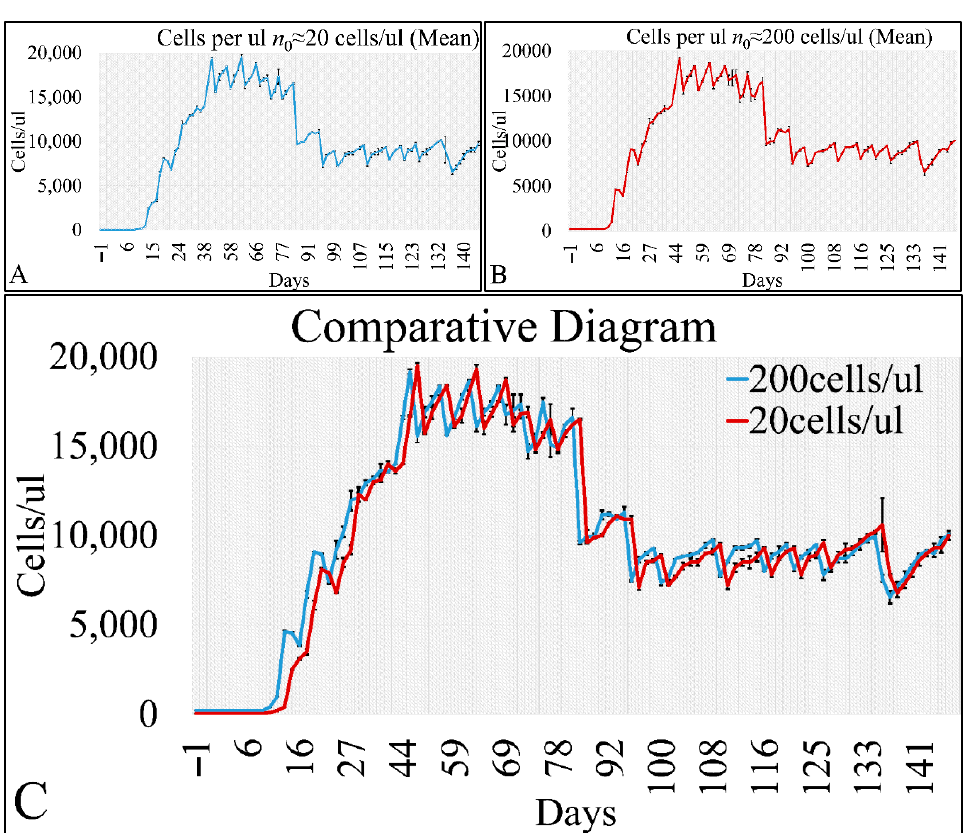
Figure 5 . The time-series presentation of the cell population CCRF-CEM with respect to cell concen- tration (cells/ μ L) and in particular, for initial cell population of ~20 cells/ μ L ( A ), ~200 cells/ μ L ( B ). Further on, the two time-series are presented together in one diagram for comparison ( C ) ( n 0 : the initial population).